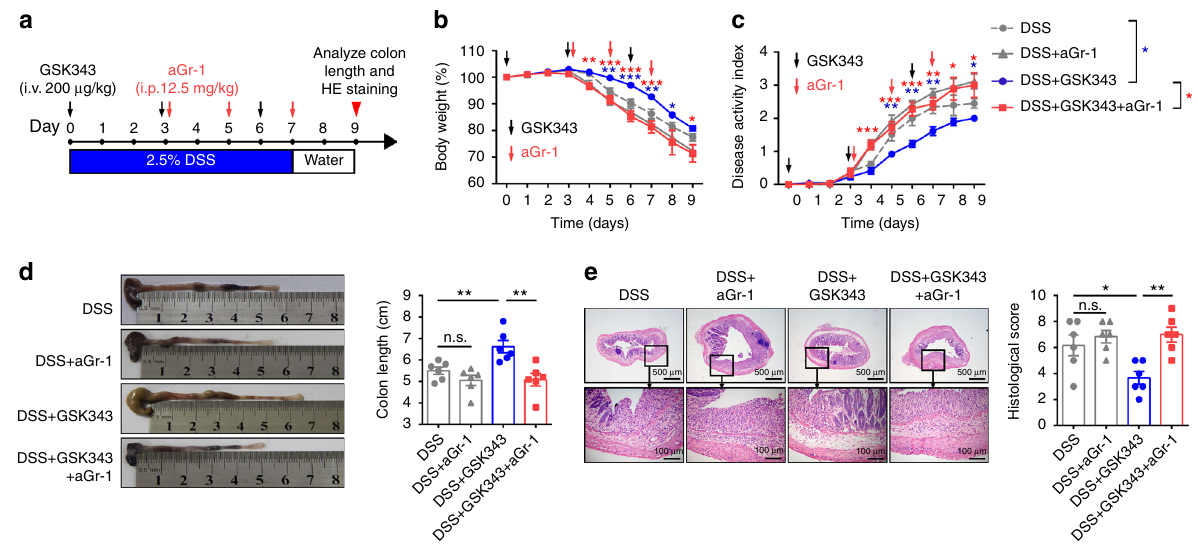
Fig. 4 MDSC depletion reverses the colitis improvement rendered by GSK343. a Experimental design of DSS-induced colitis in C57BL/6 mice and treatment schedule. b , c Body weight ( b ) and disease activity index ( c ) of DSS-exposed mice that were treated with isotype control mAbs, anti-Gr-1, GSK343 plus isotype control mAbs, or GSK343 plus anti-Gr-1 ( n = 13 per group). For statistical comparisons, blue asterisk (*) indicates DSS vs. DSS + GSK343 and red asterisk (*) indicates DSS + GSK343 vs. DSS + GSK343 + aGr-1. d Representative images of colons and colon length from the indicated treatment cohorts at day 9 after DSS treatment ( n = 6 per group). e Representative H&E staining of distal colon cross-sections and corresponding histological scores at day 9 after initial DSS exposure ( n = 6 per group). Throughout, data are representative of three independent experiments. The statistical signi fi cance of differences was determined by two-way analysis of variance with Bonferroni post test ( b , c ) and one-way analysis of variance followed by Bonferroni post test ( d , e ). * P < 0.05, ** P < 0.01, *** P < 0.001, n.s. = not signi fi cant. The results are presented as the means ± SEM. Source